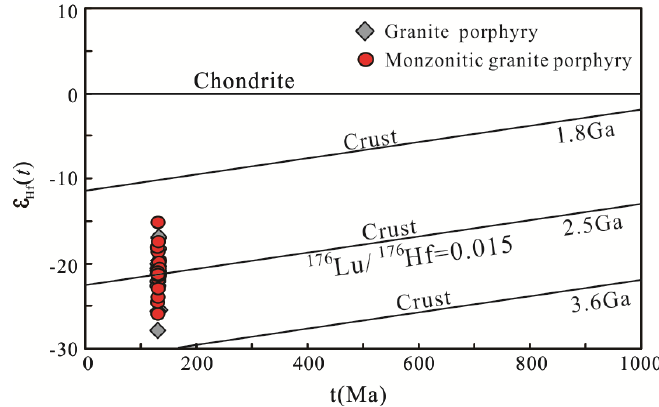
Figure 9. Diagram of ε Hf ( t )-t(Ma) for the Leimengou granite porphyry and monzonitic granite porphyry.